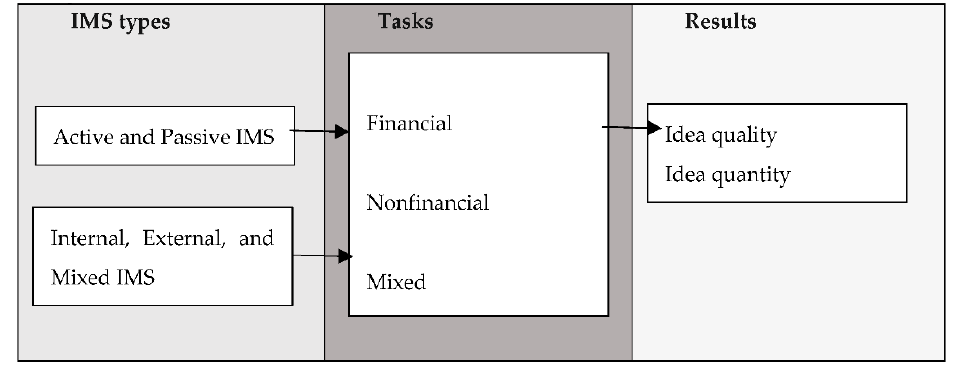
Figure 13. Research Framework.